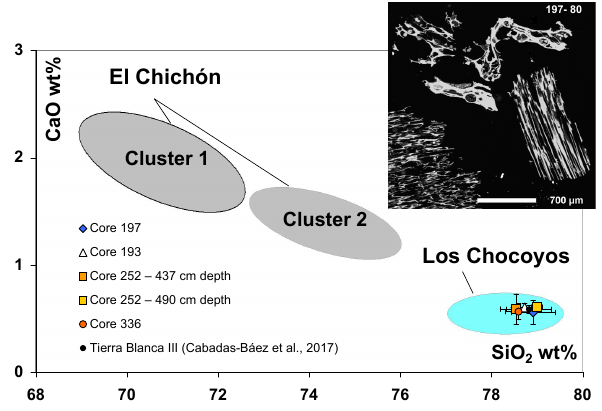
Figure 9. SiO 2 –CaO diagram for analysed volcanic glass shards plotted along with compositional characteristics of El Chichón (Nooren et al., 2017) and Los Chocoyos tephra (Kutterolf et al., 2008). Data points represent averages for 5–12 particles (bars are 1 σ ). The SiO 2 –CaO composition of volcanic glass shards recovered from Usumacinta levee deposits at Tierra Blanca III (Cabadas-Báez et al., 2017) are indicated for comparison. We refer to Table A3 for all major-element data. Inset: thin section of pumice and volcanic glass shards recovered from the beach-ridge sands (core 197; sam- ple from 80cm below the surface). Notice the elongated vesicularity of one of the pumice